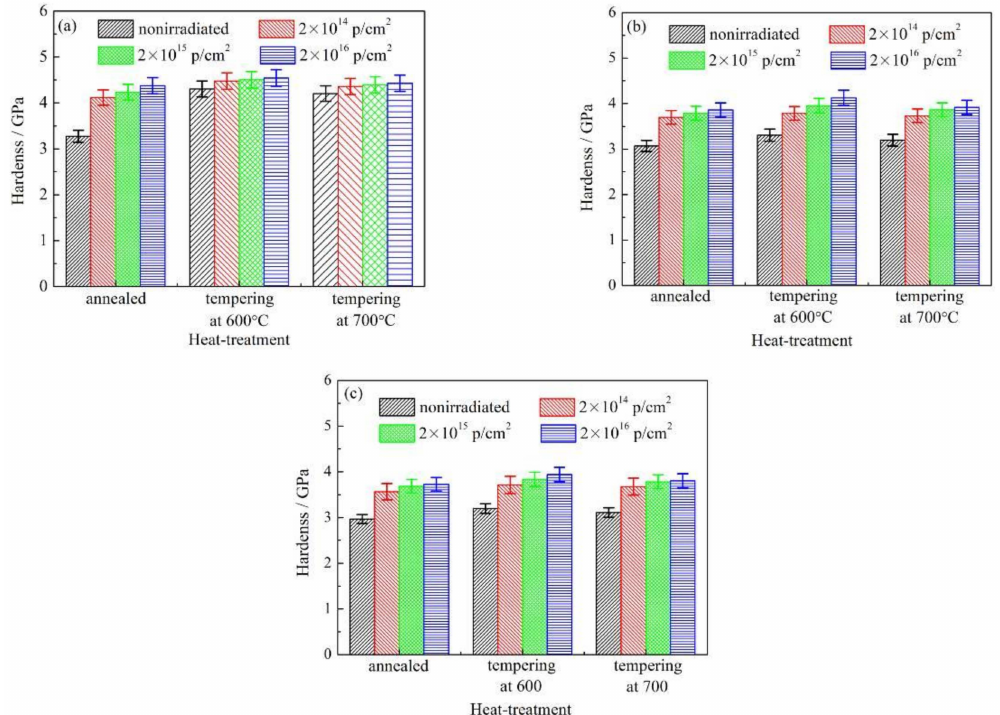
Figure 6. Nano-hardness of AISI 420 steel after proton radiation with di ff erent cumulative charges. ( a ) 2000 µ N; ( b ) 3000 µ N; ( c ) 4000 µ